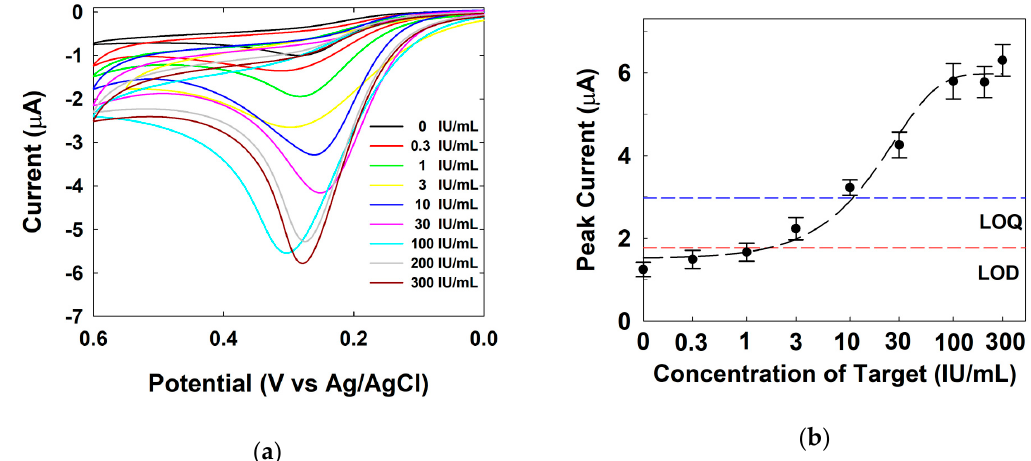
Figure 3. ( a ) Cyclic voltammogram of a sandwich-type electrochemical immunosensor for human IgE at various concentrations of target human IgE from 0 IU / ml to 100 IU / ml. Cyclic voltammograms were obtained after 10 min of enzymatic reaction time in bu ff er containing 1 mM p -APP at a scan rate of 10 mV / s. ( b ) Calibration curve for the oxidation peak current depending on the target concentration. The red dashed line represents the LOD obtained by the mean current at the zero concentration of the target IgE plus three times the standard deviation (SD). The blue dashed line represents the LOQ obtained by the mean current at the zero concentration of the target IgE plus ten times the SD. Each concentration experiment was performed at least five times. For the zero concentration (blank sample), the experiments were performed ten